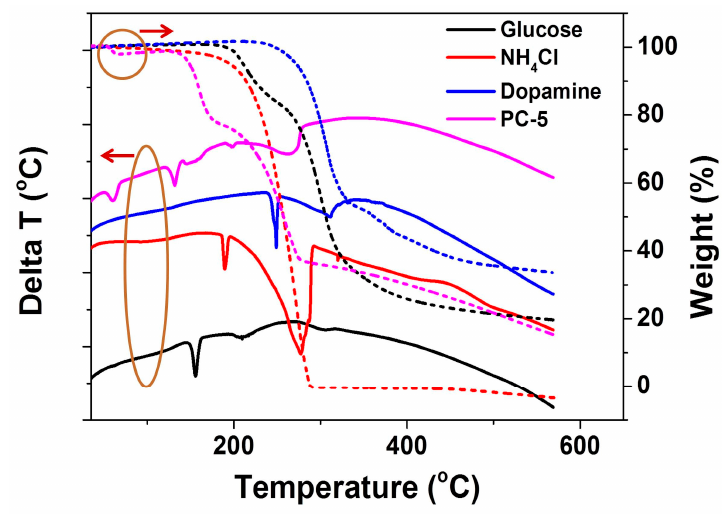
Figure 2. The DTA (differential thermal analysis) curves (solid line) and TGA (thermogravimetric analysis) curves (dash line) of glucose, NH 4 Cl, dopamine and their mixture (the precursor for PC-5).